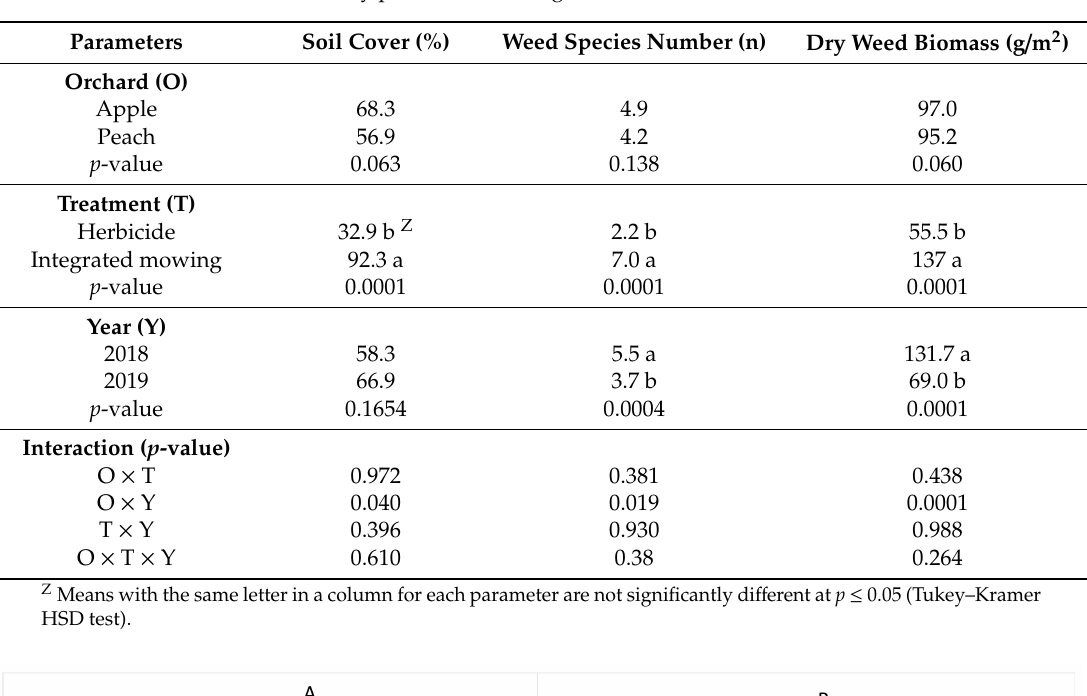
Table 2. Two-way ANOVA for the e ff ect of treatment, orchard, soil depth, sampling time, and their interactions on weed biodiversity parameters during the summer seasons in 2018–2019.